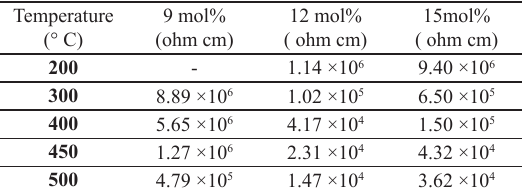
Table 5. Resistivity of 3 compositions vs Temperature by Two Probe Method .